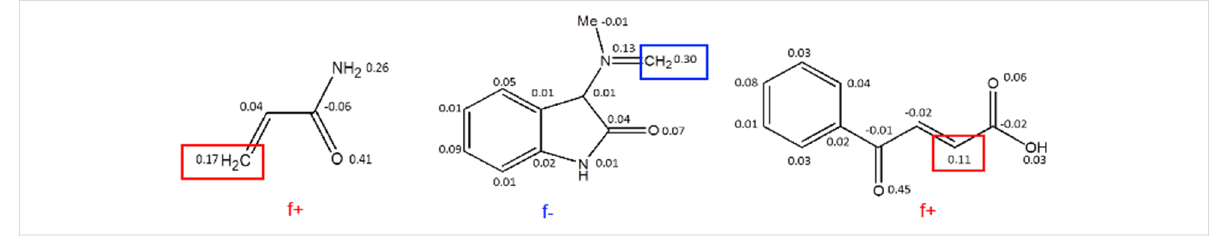
Figure 6: The Fukui function indices of acrylamide, azomethine ylide and benzoylacrylic acid.